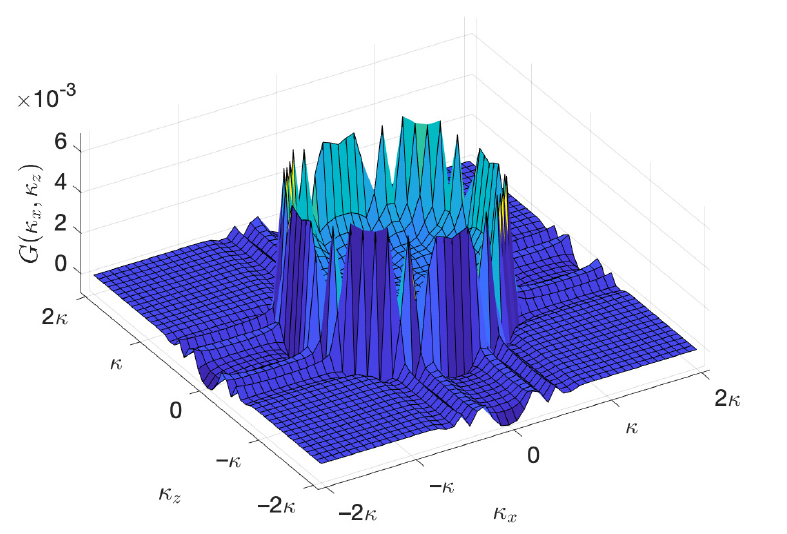
Figure 4. Fourier transform G ( κ x , κ z ) in (23) of the truncated and discretized spatial correlation function g ( ∆ x , ∆ z ) in (18) with L x = L z = 12 λ and d x = d z = λ /3. Note that κ x and κ z are expressed in terms of the wavenumber κ , which is directly labeled on the abscissa and ordinate, while G ( κ x , κ z ) is dimensionless since g ( ∆ x , ∆ z ) is